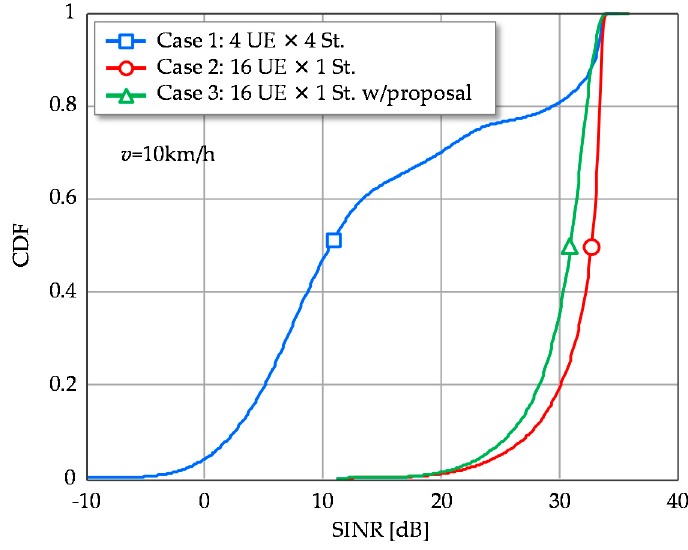
Figure 5. Cumulative distribution functions (CDFs) of SINR per signal stream.